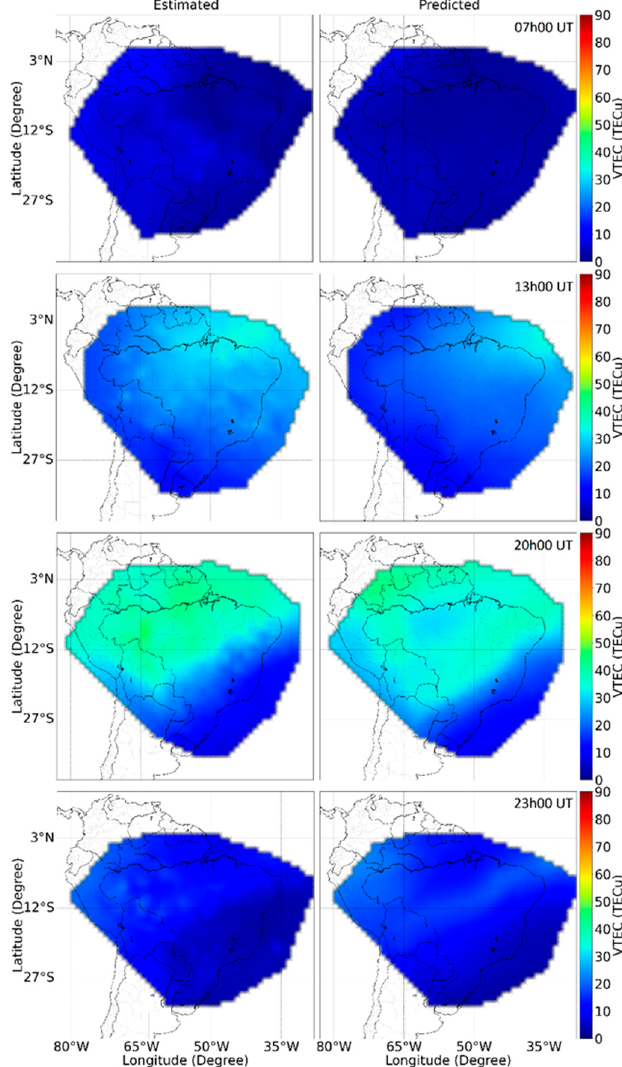
Figure 7. Comparison between the real VTEC maps ( left ) and the VTEC maps predicted with the MLP-NN ( right ) during a winter solstice arbitrary day (6 June 2014). From upper to lower panels, frames corresponding to the post-midnight, morning, afternoon, and early nighttime are presented.